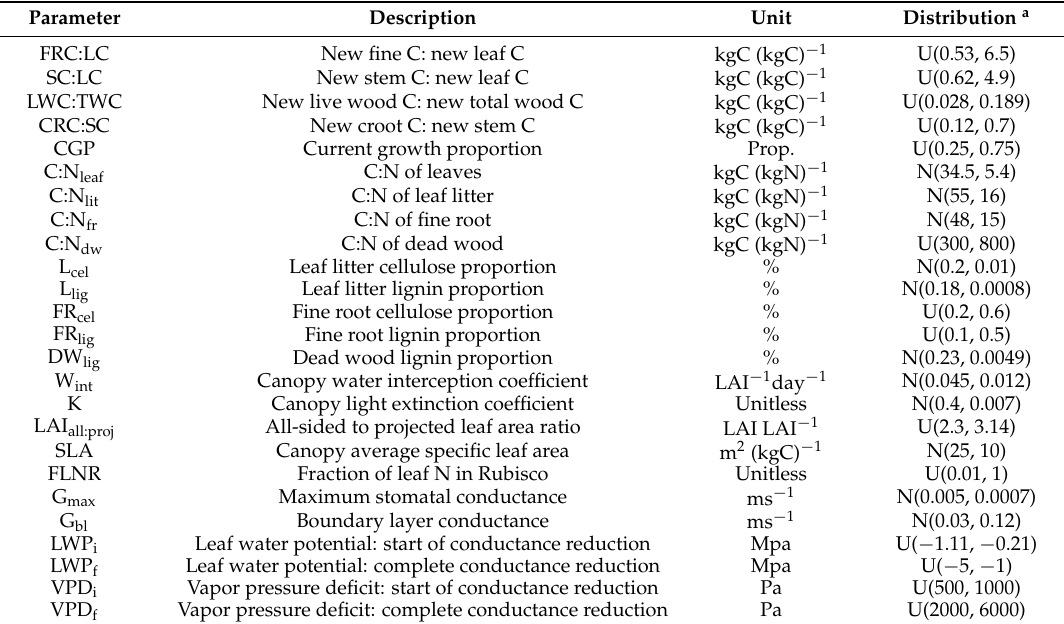
Table 1. Distribution of Biome-BGC crucial ecophysiological parameters